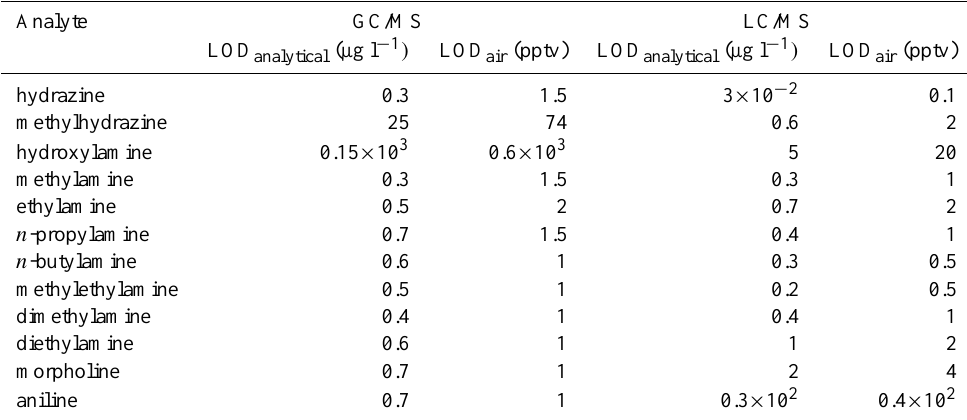
Table 1. Sensitivity of Analytical Methods to Compounds of Trace Atmospheric Amino Compounds; LOD analytical , analytical sensitivity (3 SD); LOD air , corresponding sensitivity in a sampled air stream assuming 3h of sampling at 10lmin − 1 .